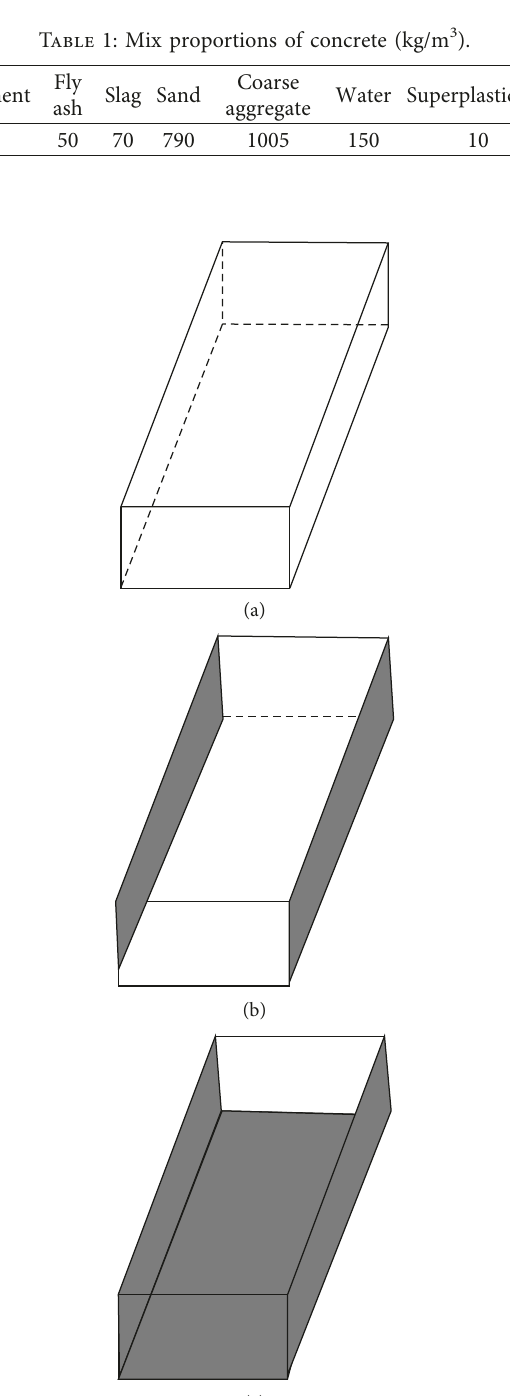
Figure 1: Schematic of CPF liner paste method. (a) No CPF. (b) Lateral surfaces covered by CPF. (c) Three surfaces covered by